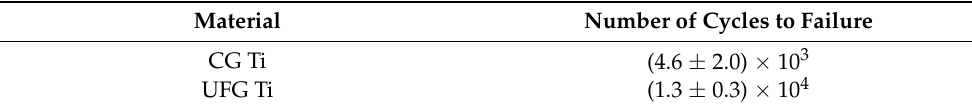
Table 5. Average plate life.